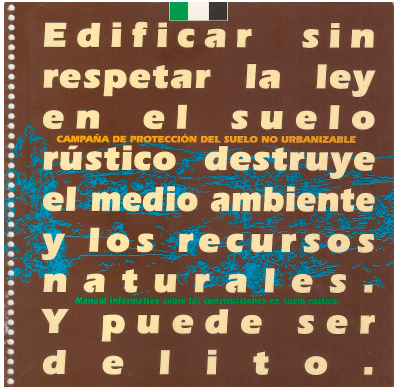
Figure 2. Cover of the informative manual on the constructions in Undevelopable Land (UL).